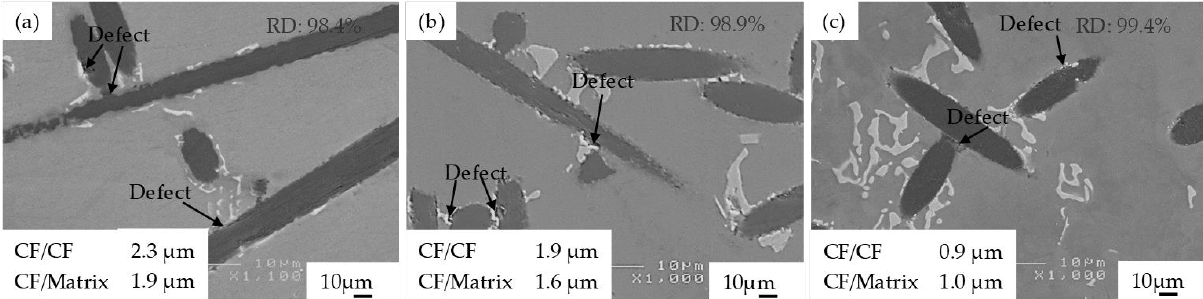
Figure 4. SEM images of pores of composites (0.8 MPa): ( a )(a’) Ni plated CSF/A1070 composite, ( b ) (b’) Ni plated CSF/A356 alloy composite, and ( c ) (c’) Ni plated CSF/A336 alloy composite.